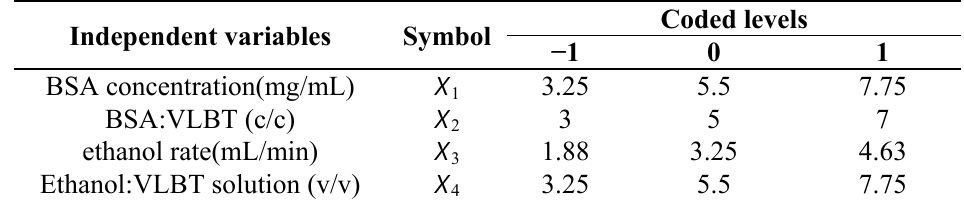
Table 3. Factors and their levels in response surface methodology ( RSM) designs. Independent